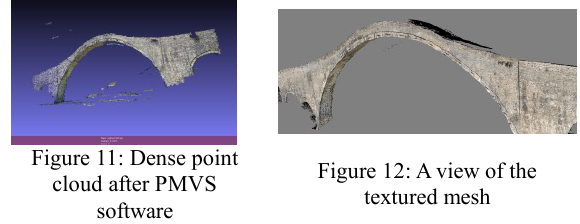
Figure 12: A view of the textured